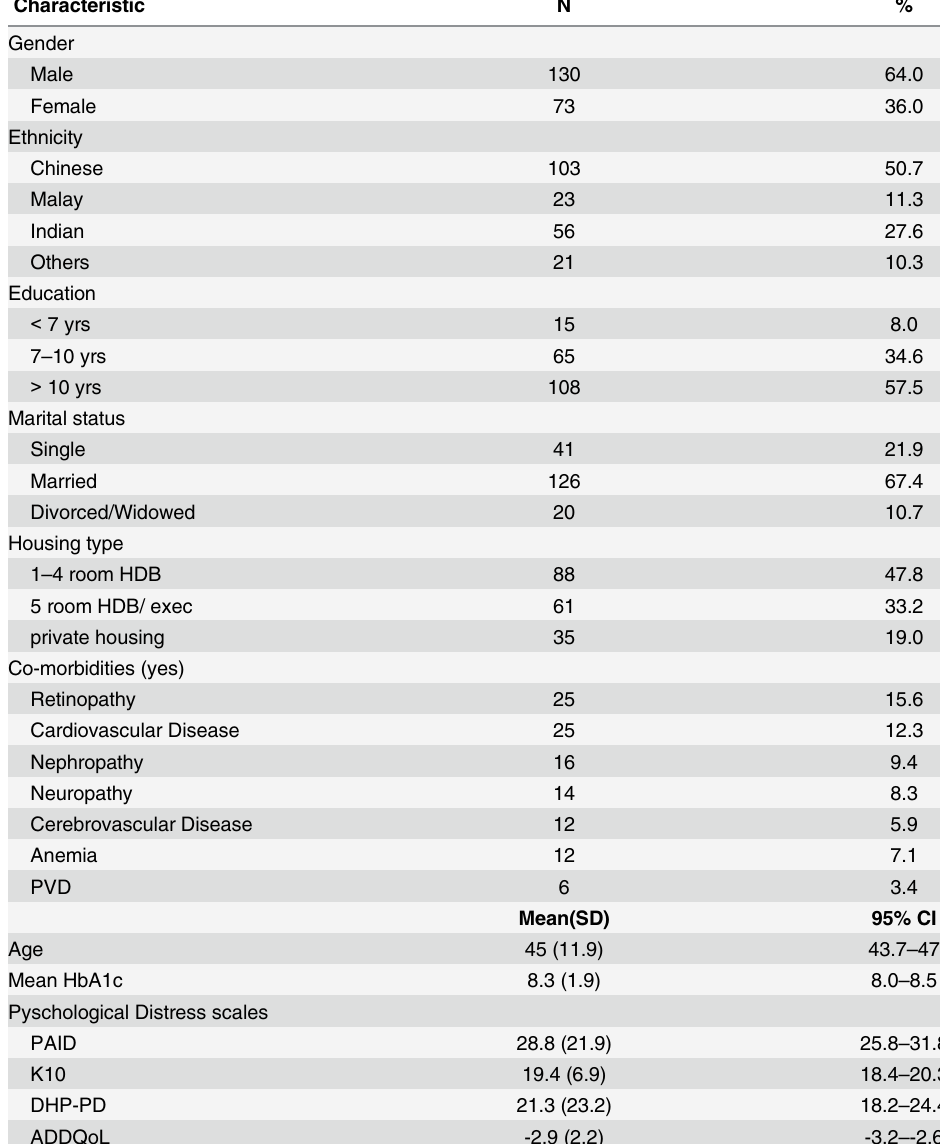
Table 1. Characteristics of participants in the study (N =